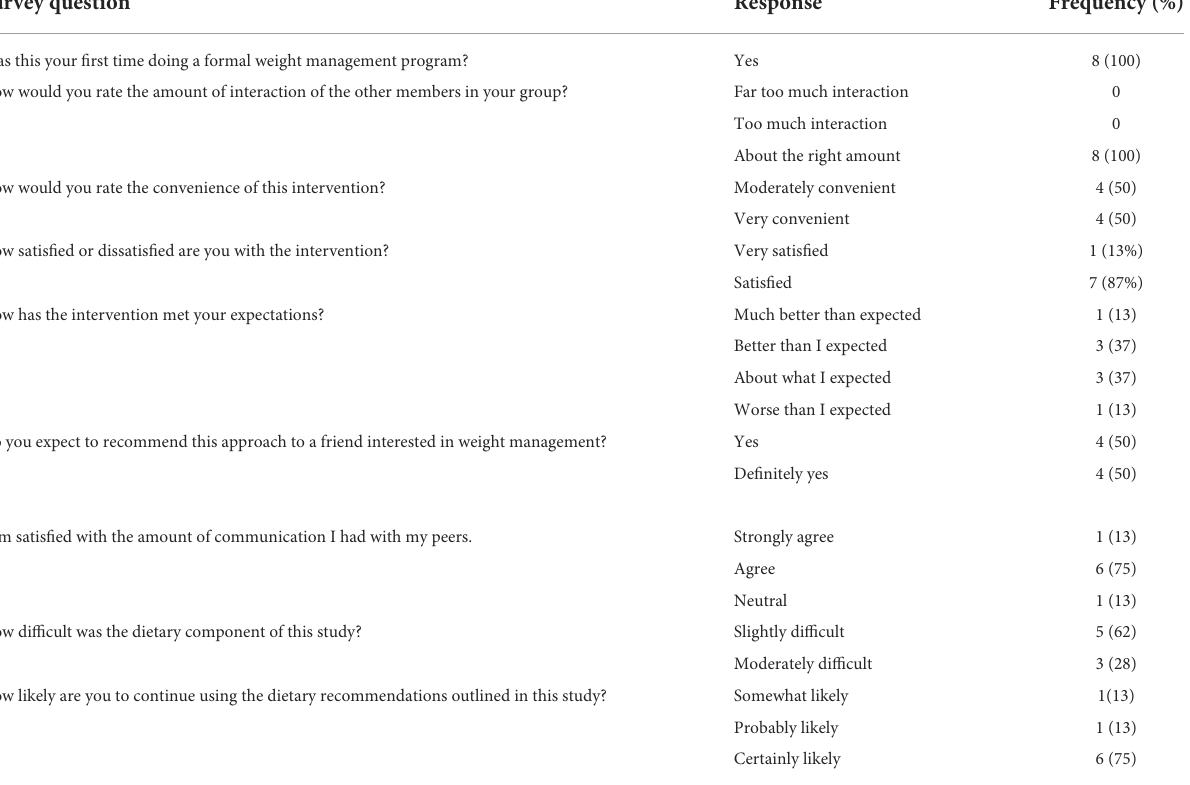
TABLE 4 Responses to end study survey ( n = 8).